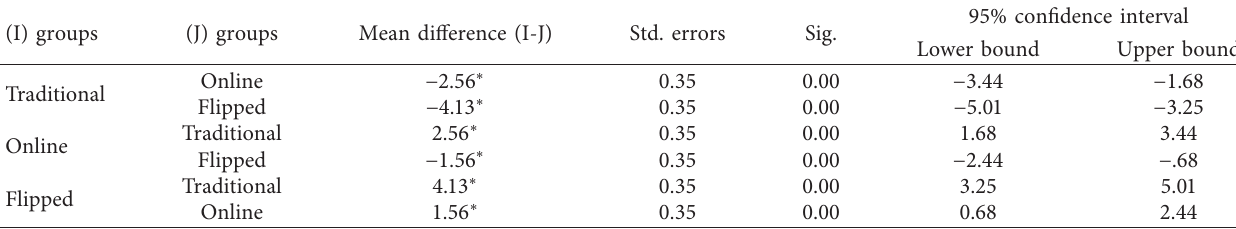
Table 5: Post hoc Scheffe test and multiple comparisons (posttest of